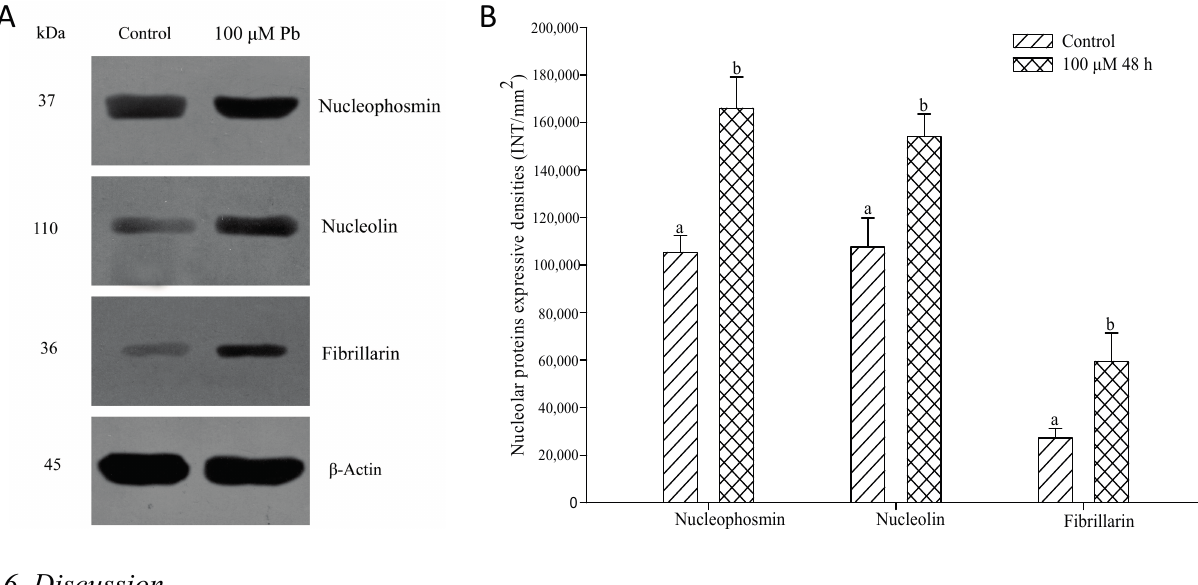
Figure 7. Effect of Pb (100 μ M Pb, 48 h), on the expression of nucleophosmin, nucleolin and fibrillarin. Bands were detected by western blotting ( A ) and their intensities were measured by “Quantity One” software (Bio-Rad, Berkeley, CA, USA) ( B ). Bar indicates standard error (SE). n = 5. p <